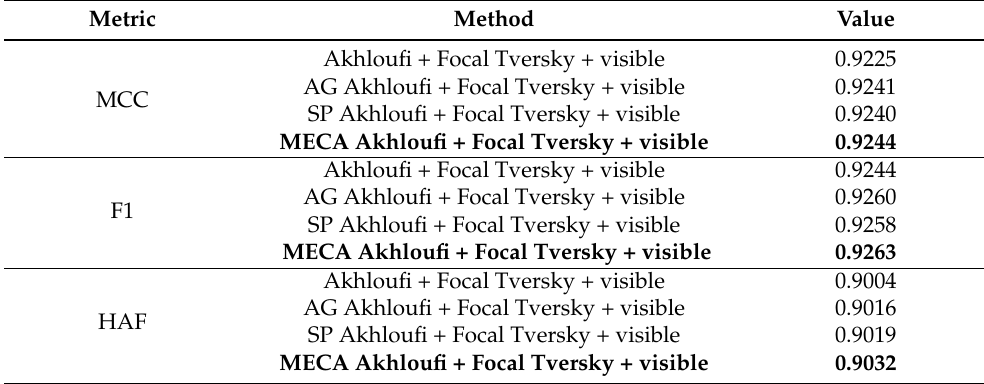
Figure 21. In-detail structure of the model proposed by Akhloufi et al. [38] with the inclusion of MECA modules. The numbers inside the squares represent the number of filters in the corresponding layer. Table 4. Comparison the best combination with and without attention modules. The best combination per metric is highlighted in